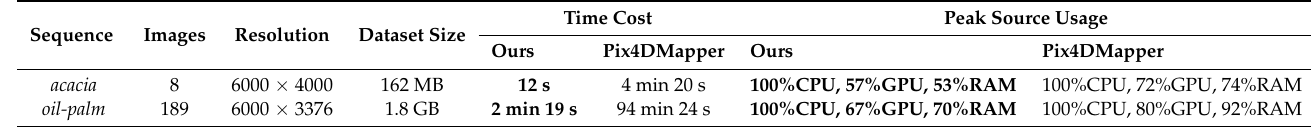
Table 1. Time usage and peak source usage statistics for processing sequential aerial images dataset. The results show that our algorithm is much faster than other commercial software Pix4DMapper with less hardware resources usage.